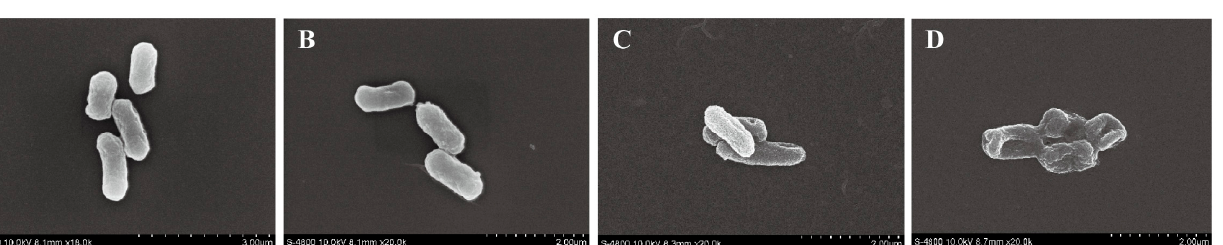
Figure 10. The effect of eugenol on the cell morphology of Sh. flexneri . ( A ) Untreated Sh. flexneri cells. ( B ) Sh. flexneri treated with eugenol at MIC. ( C ) Sh. flexneri cells treated with eugenol at 2MIC. ( D ) Sh. flexneri cells treated with eugenol at 4MIC.